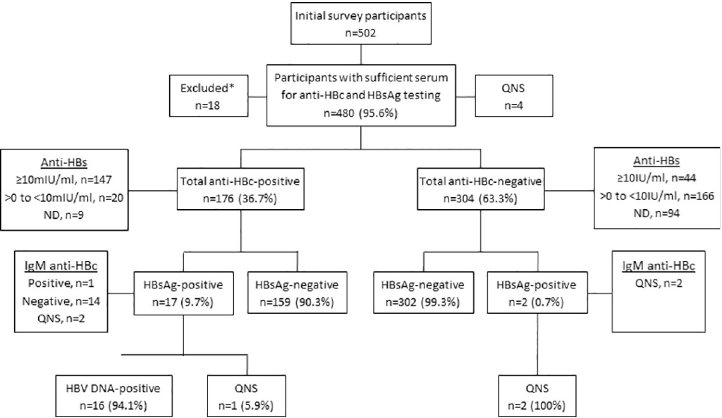
Fig 1. Hepatitis B virus (HBV) testing with results, 2011 Guyana Defense Force Seroprevalence and Behavioral Epidemiology Risk Survey for HIV and sexually transmitted infections. Abbreviations: Anti-HBc, antibody to hepatitis B core antigen; Anti-HBs, antibody to hepatitis B surface antigen; DNA, deoxyribonucleic acid; HBsAg, hepatitis B surface antigen; HBV, hepatitis B virus; IgM, immunoglobulin M; mIU/ml, milli-international units per milliliter; ND, not detected; QNS, quantity not sufficient for